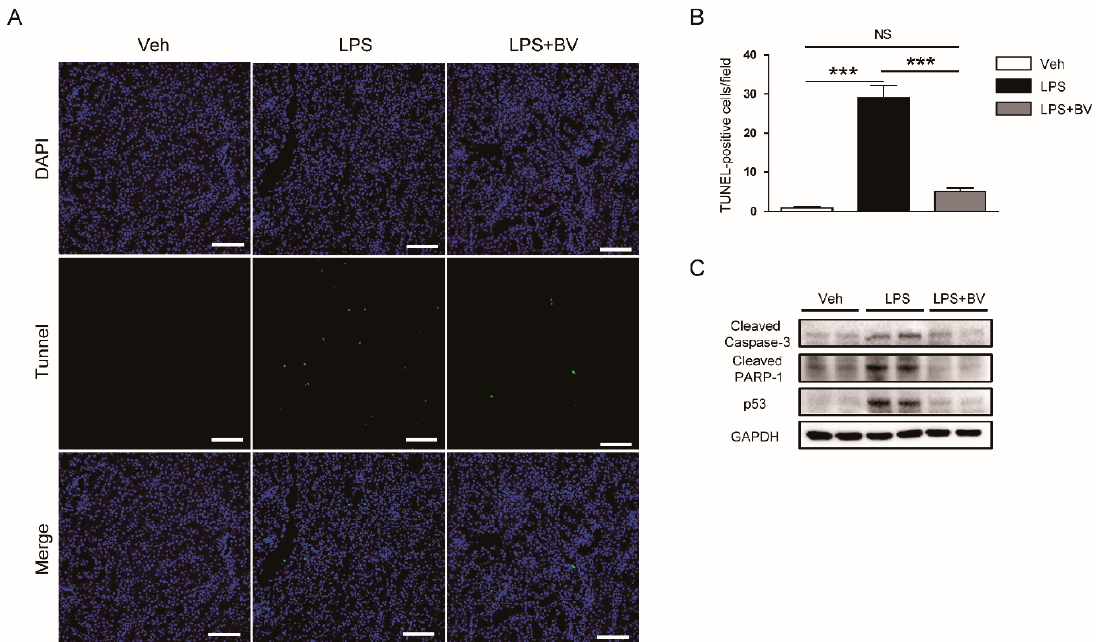
Figure 7. Bee venom reduced tubular cell apoptosis in LPS-treated mice. ( A ) Terminal deoxynucleotidyl transferase-mediated deoxyuridine triphosphate nick end labeling (TUNEL) staining in kidneys. Bar = 100 μ m. ( B ) Number of TUNEL-positive cells. ( C ) Representative images of Western blotting of cleaved caspase-3, cleaved poly(ADP-ribose) polymerase-1 (PARP-1), p53, and GAPDH in kidneys. n = 8 per group. *** p < 0.001. NS, not